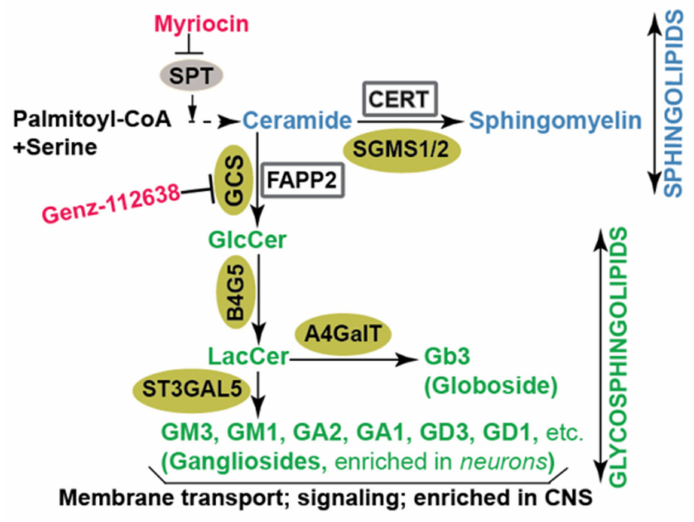
Figure 1. Diagram of sphingolipid biosynthetic pathways in mammalian cells. The initial step in the de novo biosynthesis of sphingolipids is the conversion of serine and palmitoyl CoA to ceramide. Following that, ceramide is subjected to conversion to sphingomyelin or to various glycosphingolipid intermediates on their way to becoming complex glycosphingolipids. The enzymes involved in the synthesis of sphingolipids and glycosphingolipids are denoted in gold. Chemical inhibitors of key enzymes are indicated in red. SGMS1 / 2: sphingomyelin synthase; GCS: glucosylceramide synthase; B4G5: lactosylceramide synthase; ST3GAL5: lactosylceramide alpha-2,3-sialyltransferase or GM3 synthase; A4GalT: alpha 1,4-galactosyltransferase or Gb3 synthase; SPT: serine palmitoyl